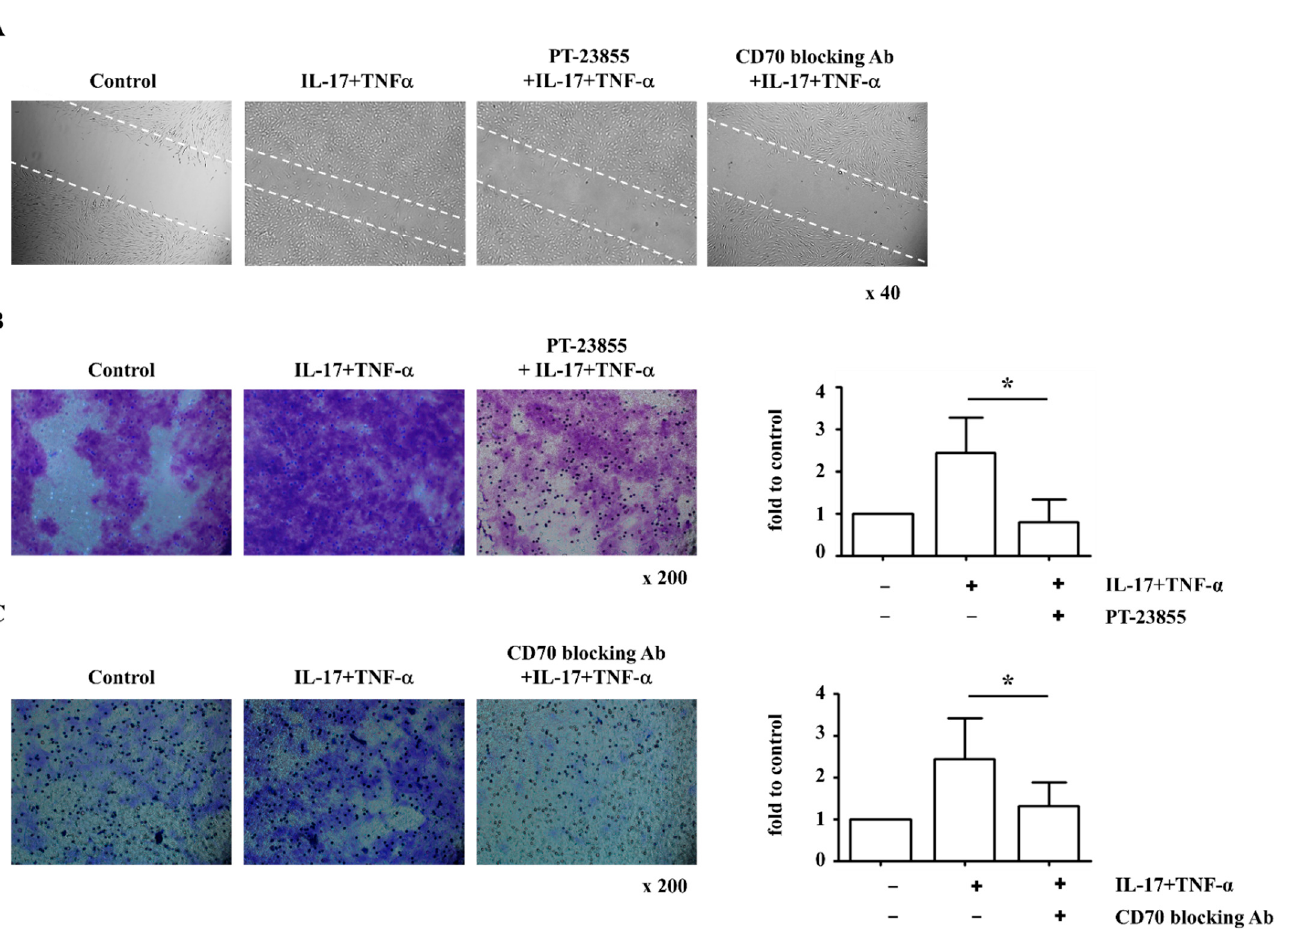
Figure 5. IL-17- and TNF- α -induced migration is attenuated by inhibiting CD70 or HIF-2 α . ( A ) RA FLS were cultured with or without IL-17 (5 ng/mL) and TNF- α (5 ng/mL) for 24 h. To inhibit HIF-2 α , 20 μ M PT-2385 was added to the culture for 24 h. To inhibit CD70, 1 μ g/mL BU69 was added to the culture for 24 h. Following the scratch assay, migrated cells were photographed after cytokine stimulation for 24 h. Magnification is 40×. ( B , C ) Cell migration of RA FLS ( n = 4) was measured using a transwell chamber after 16 h and visualized with crystal violet staining. Following solubilization, the crystal violet dye was quantitated using optical density. Data represent the fold change of the optical density compared to control. Statistical analysis was performed using a Mann–Whitney test. Magnification is 200×. * indicates p < 0.05.